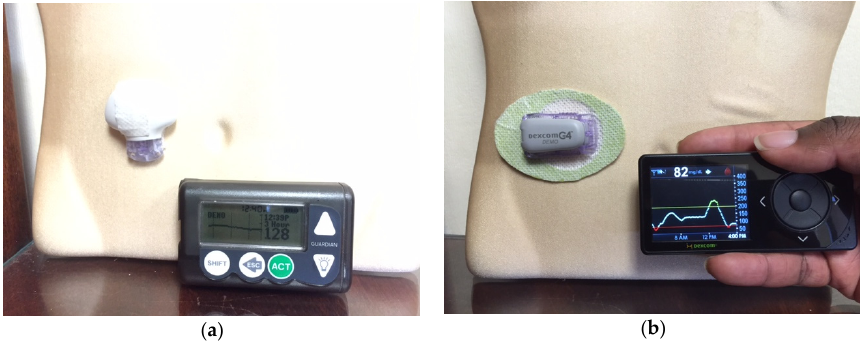
Figure 5. Personal Continuous Glucose Monitors: ( a ) the Medtronic Guardian ; and ( b ) the Dexcom ‐ 7 .